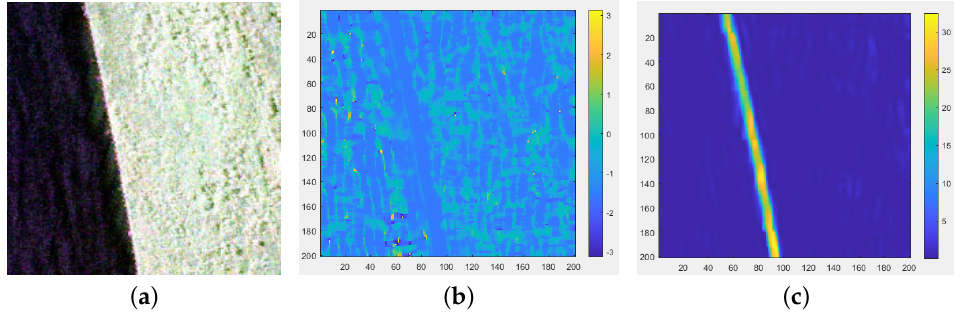
Figure 3. Gradient map. ( a ) PauliRGB map. ( b ) Gradient direction map. ( c ) Gradient strength